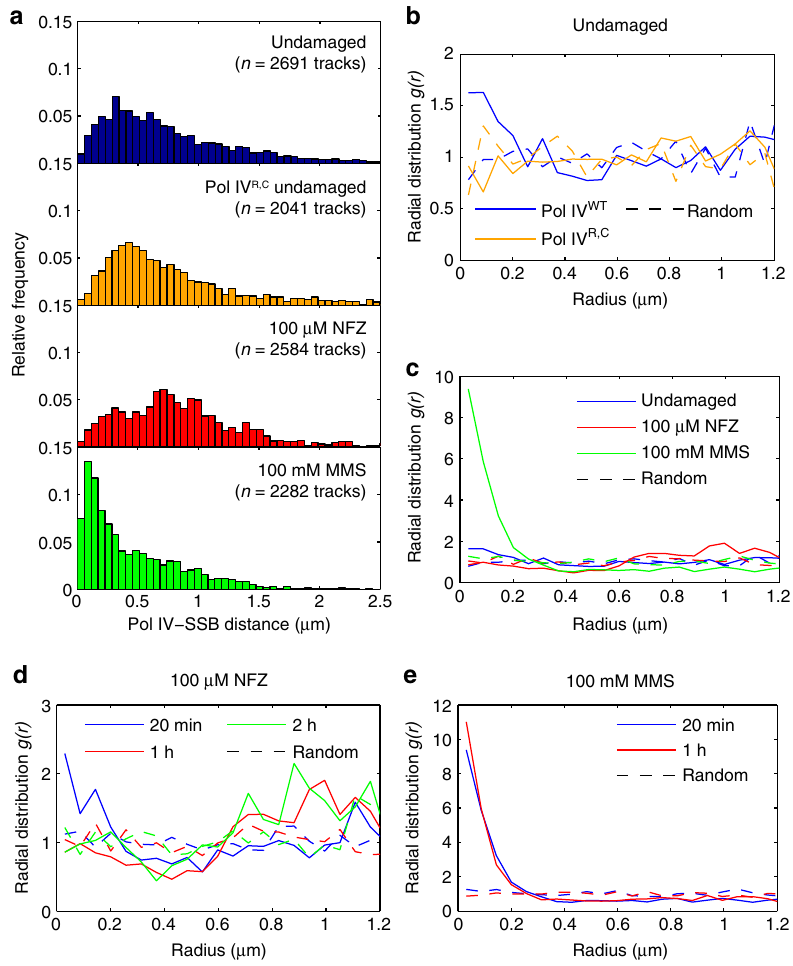
Fig. 3 Single-cell colocalization of Pol IV-PAmCherry and SSB-mYPet in undamaged, NFZ-treated, and MMS-treated cells. a Distributions of the mean distance between each static Pol IV track and the nearest SSB focus for Pol IV WT (top) and Pol IV R,C (top center) in undamaged cells and for Pol IV WT in cells treated with 100 µ M NFZ (bottom center) or 100 mM MMS (bottom). b Radial distribution functions g(r) for the undamaged distance distributions in a . c Radial distribution functions g(r) for the damaged Pol IV WT distance distributions in a . d Radial distribution functions g(r) for Pol IV WT in cells treated with 100 µ M NFZ for 20 min, 1 h, or 2 h. e Radial distribution functions g(r) for Pol IV WT in cells treated with 100 mM MMS for 20 min or 1 h. Also shown in panels b – e are random g(r) functions for each data set. Several Pol IV WT g(r) traces are replotted to enable